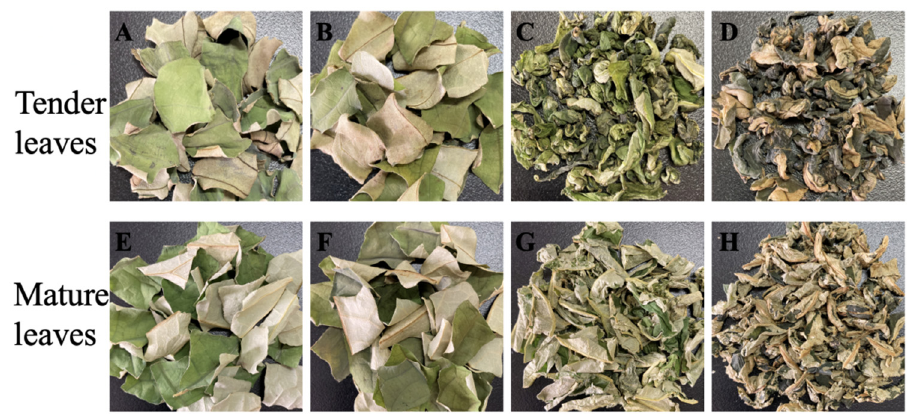
Figure 1. The appearance of lotus-leaf teas with different processing methods. ( A ) TNT, ( B ) THT, ( C ) TGT, ( D ) TBT, ( E ) MNT, ( F ) MHT, ( G ) MGT, ( H ) MBT. The lotus-leaf teas were ground into powder, and 1.0 g of the samples was put into a 200 mL conical flask, and then soaked in hot water at 1:20 ratio ( w / v ) in a 80 °C water bath